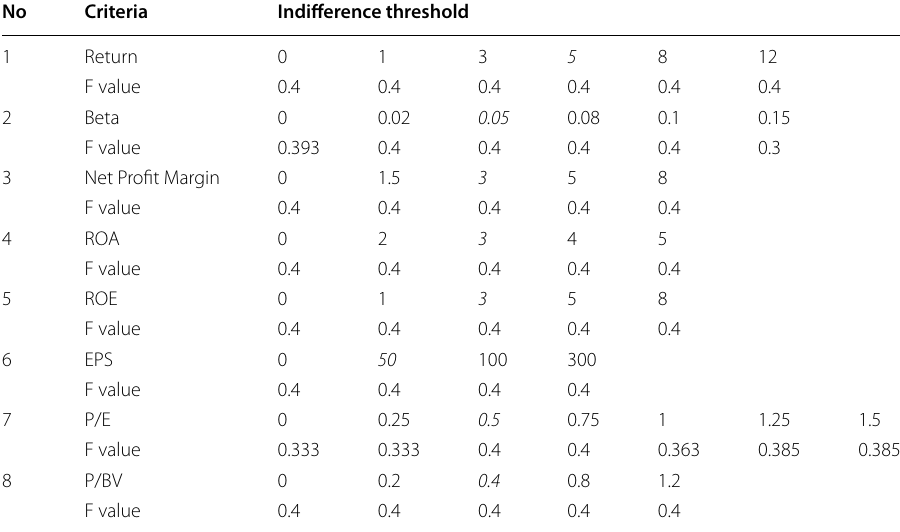
Table 13 Sensitivity analysis on the indifference threshold in ELECTRE-TRI No Criteria Indifference threshold